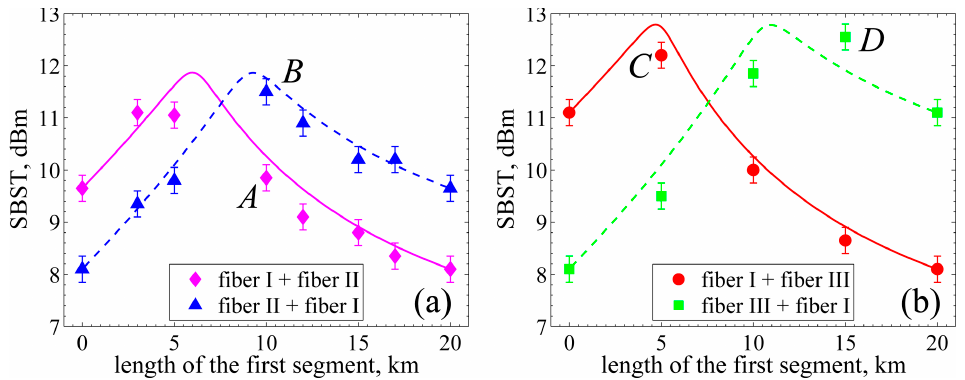
Figure 10. TheSBS thresholds of the concatenated fibers, ( a ) concatenation of fiber I and II, ( b ) concatenation of fiber I and fiber III. A is fiber I + fiber II, indicating that the front segment is fiber I and the backend is II, and same for B, C, D. [Reprinted/Adapted] with permission from [61] © The Optical Society .